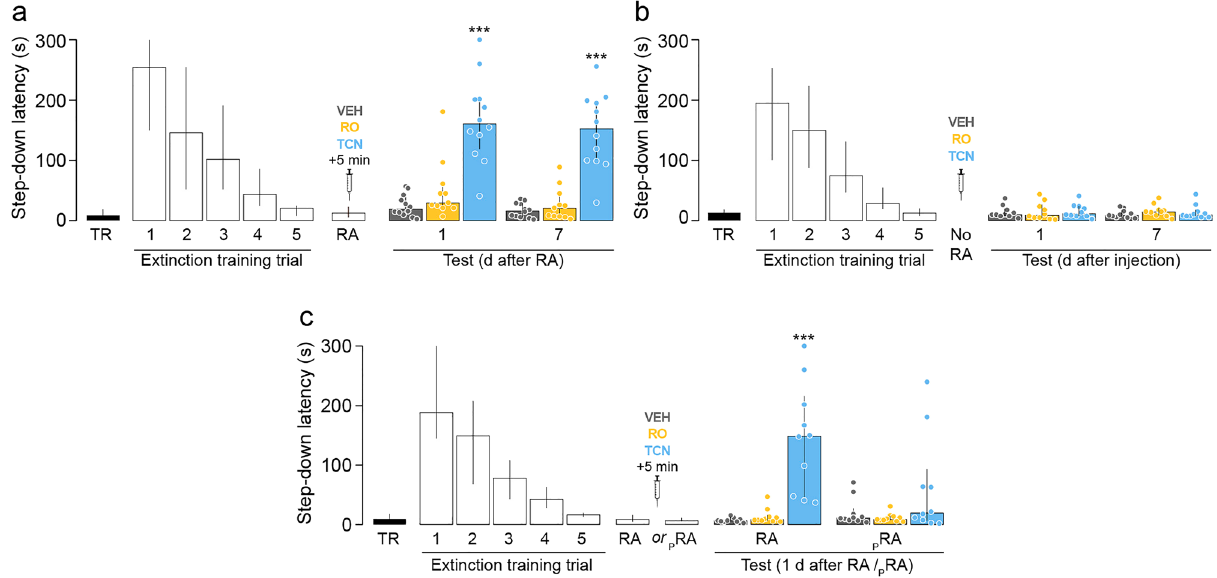
Figure 3. GluN2A-NMDARs are required for SDIA extinction memory restabilization. ( a ) Animals were trained in SDIA (TR; 0.4 mA/2 s) and, beginning 24 h later, they were submitted to one daily extinction training trial for 5 consecutive days. Twenty-four hours after the last extinction training trial, SDIA extinction memory was reactivated (RA) and, 5 min thereafter, the animals received bilateral intra-dorsal CA1 infusions of vehicle (VEH; 0.1% DMSO in saline), the GluN2B-containing NMDAR antagonist RO25-6981 (RO; 2.5 µg/side), or the GluN2A-containing NMDAR antagonist TCN201 (TCN; 0.05 µg/side). Retention was assessed 1 day and 7 days later (Test). ( b ) Animals were treated as in A except that RA was omitted (No RA). ( c ) Animals were treated as in A, but a group of them received bilateral intra-CA1 infusions of VEH, RO or TCN 5 min after a pseudo- reactivation extinction session (pRA) carried out in an SDIA training box modified to be non-aversive (NA) for SDIA-trained animals. The non-aversive box was similar in dimensions to the SDIA-training apparatus but was painted gray and the elevated platform was made of transparent plexiglass instead of wood. Data are expressed as median ± IQR. (***) p < 0.001 versus VEH in Dunn’s multiple comparisons after Kruskal–Wallis test; n = 10–12 animals per